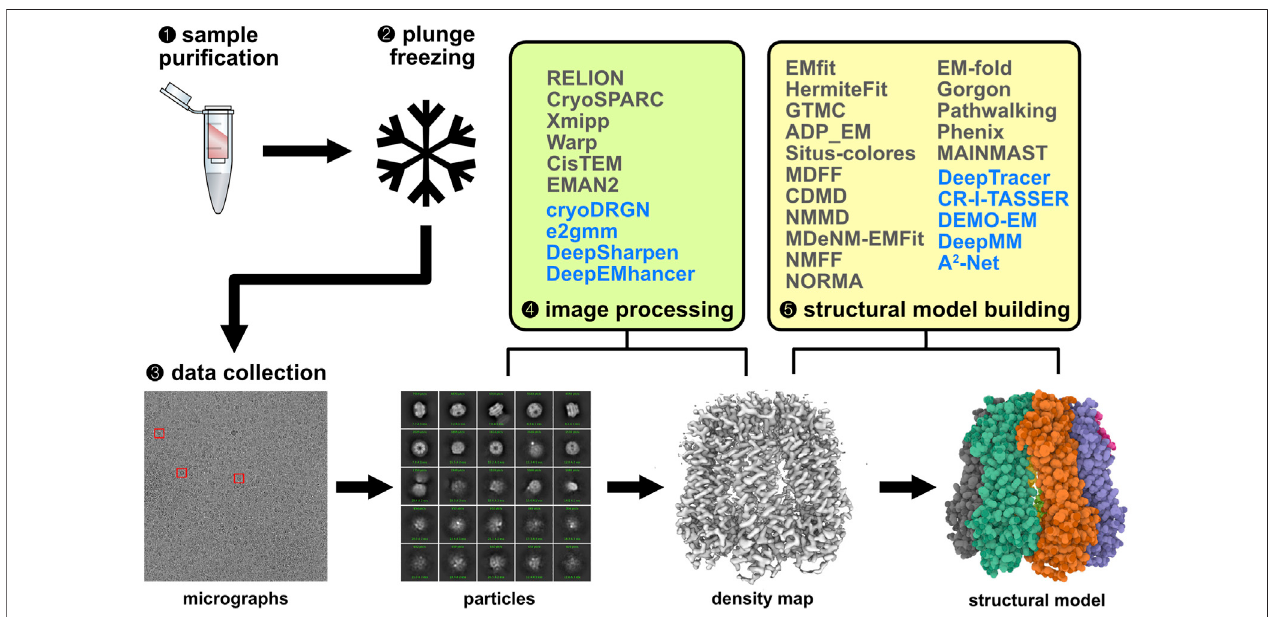
FIGURE 2 | Singe-particle cryo-EM work fl ow and relevant computational methods. Traditional methods for image processing and structural model building are shown in grey and ML-based methods in blue. Electron micrographs and particle images were visualized using cryoSPARC (Punjani et al., 2017). The density map and structural model were generated using Mol* viewer (Sehnal et al.,